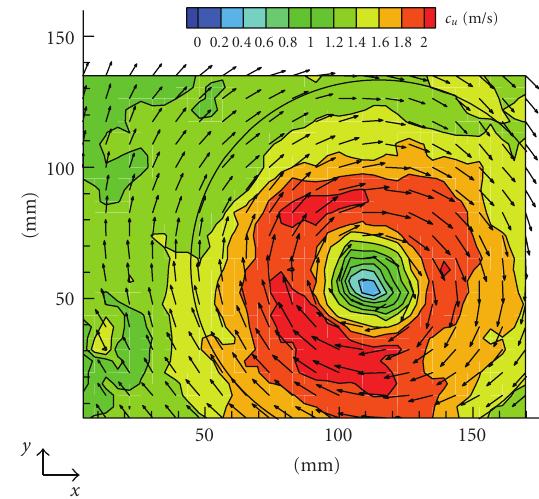
Figure 12: Prerotation at original casing at stall conditions, Q/Q opt = 0 . 3, 4 L upstream of the rotor. c u = ( u 2 + v 2 ) 1 / 2 .